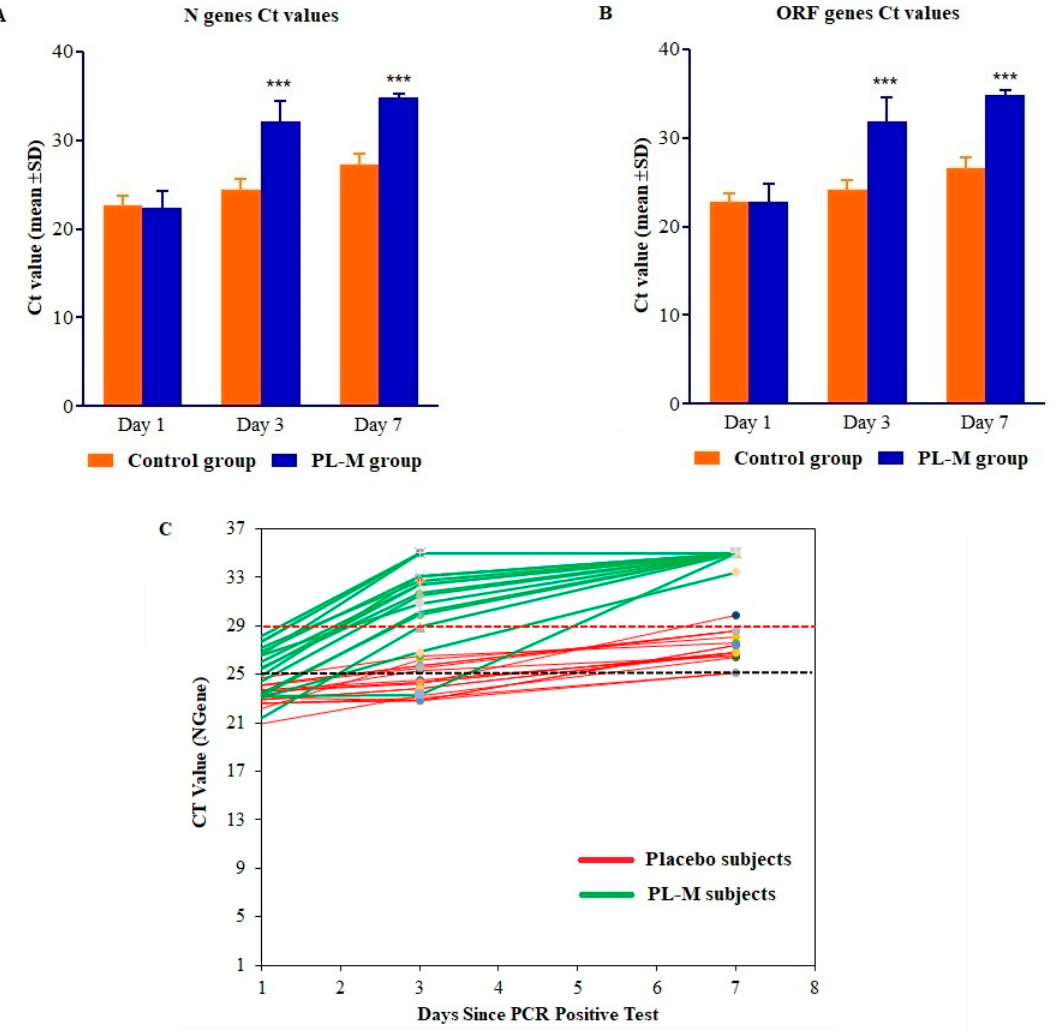
Figure 1. RT-PCR profiles of ( A ) the N gene, ( B ) the ORF gene, and ( C ) change in Ct value of individual subjects in the placebo and PL-M groups. RT-PCR profiles of N and ORF genes detected SARS-CoV-2 in COVID-19 patients on days 1, 3, and 7. About 82.35% of patients in the PL-M group (n = 17) became RT-PCR-negative for N and ORF genes (cycle counts > 29) on day 3 and all patients by day 7. All patients in the placebo group (n = 17) remained RT-PCR-positive for N and ORF genes on days 3 and 7 (cycle counts < 29). Changes in RT-PCR cycle counts for N and ORF genes in the PL-M group at days 3 and 7 were statistically significant compared to the placebo group ( p = 0.001)***.